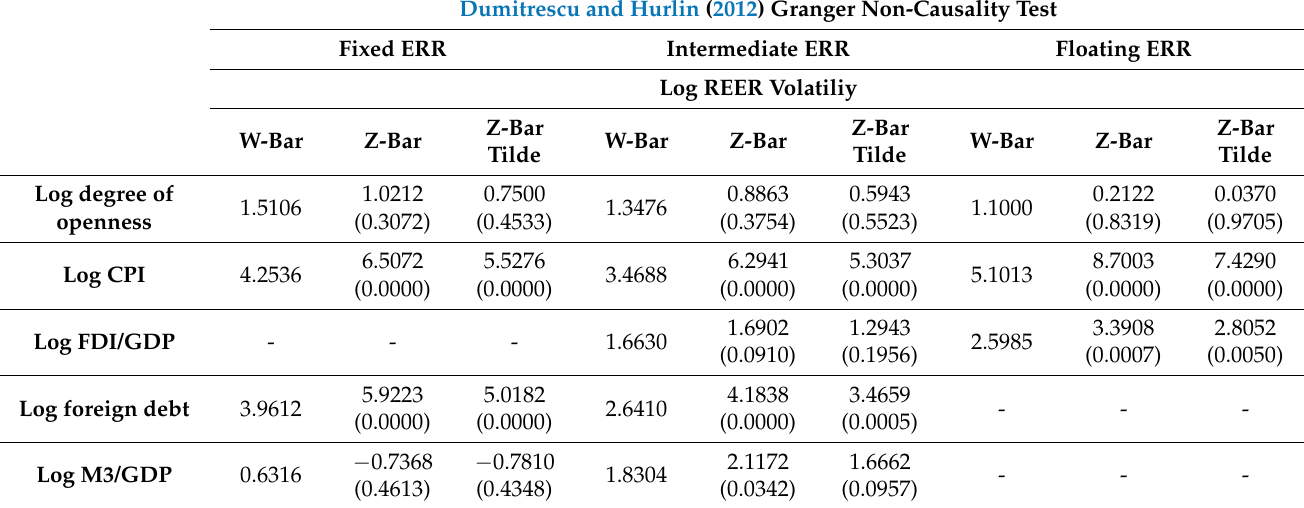
Table 14. Granger non-causality test results by exchange rate